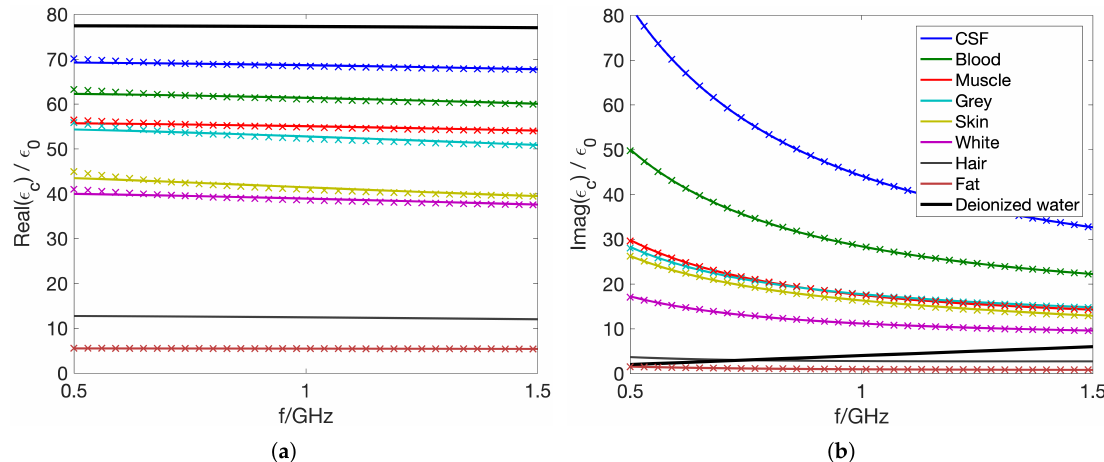
Figure 2. This figure shows the real ( a ) and imaginary ( b ) part of the complex permittivity of the tissues as a function of frequency. Solid lines represent the fitted Debye models, and cross-shaped markers show sampled values of the original Cole–Cole data